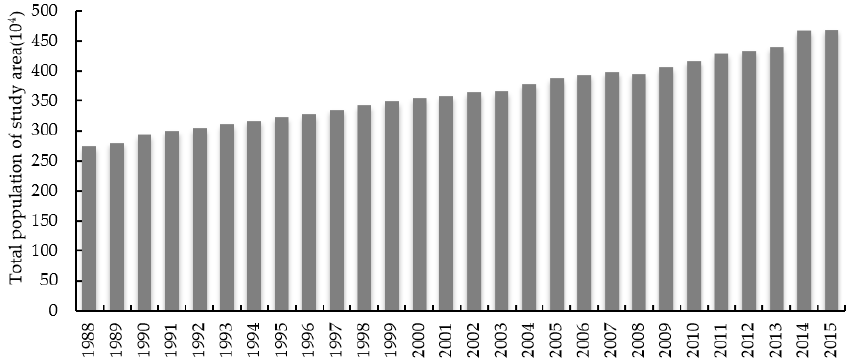
Figure 10. Total population of study area (source: [22]).